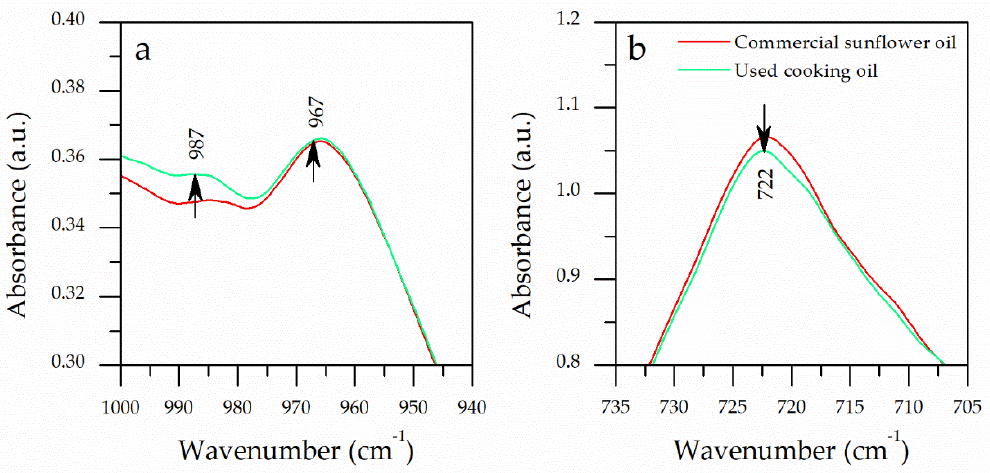
Figure 3. Comparison of the FT-IR spectra of different sunflower oils: ( a ) Trans isomers region, ( b ) cis isomers region.